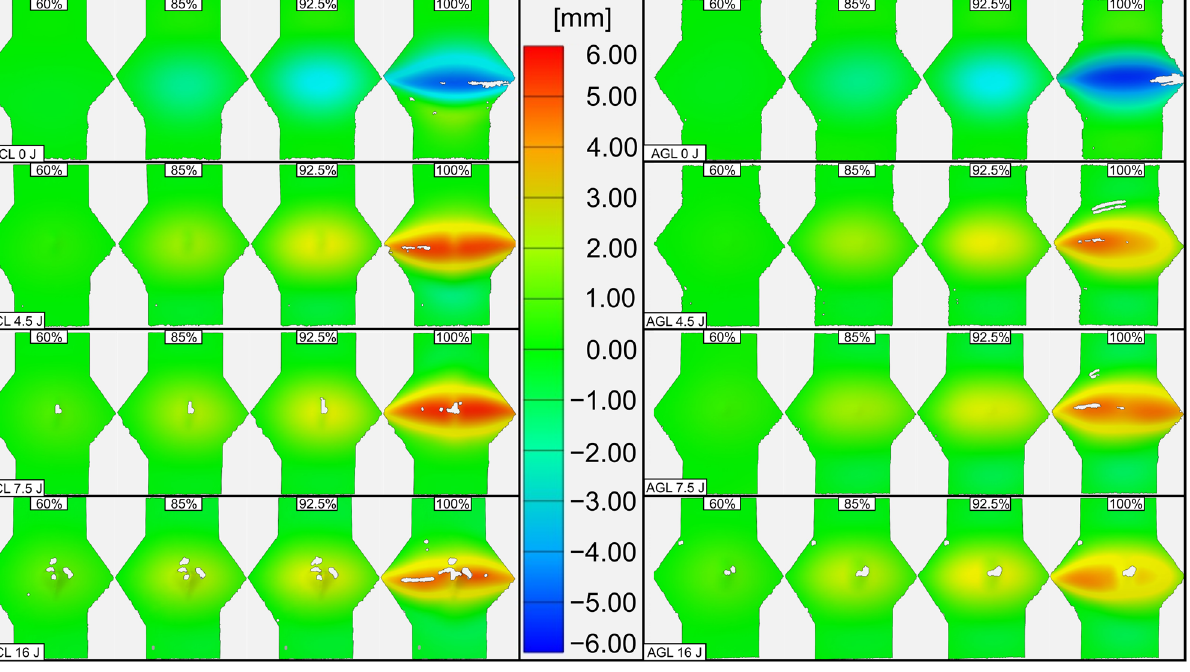
Figure 10. Z -axis deformation maps of compressed plates registered by DIC system. Displacement was the most visible after reaching the buckling state during the CAI test.